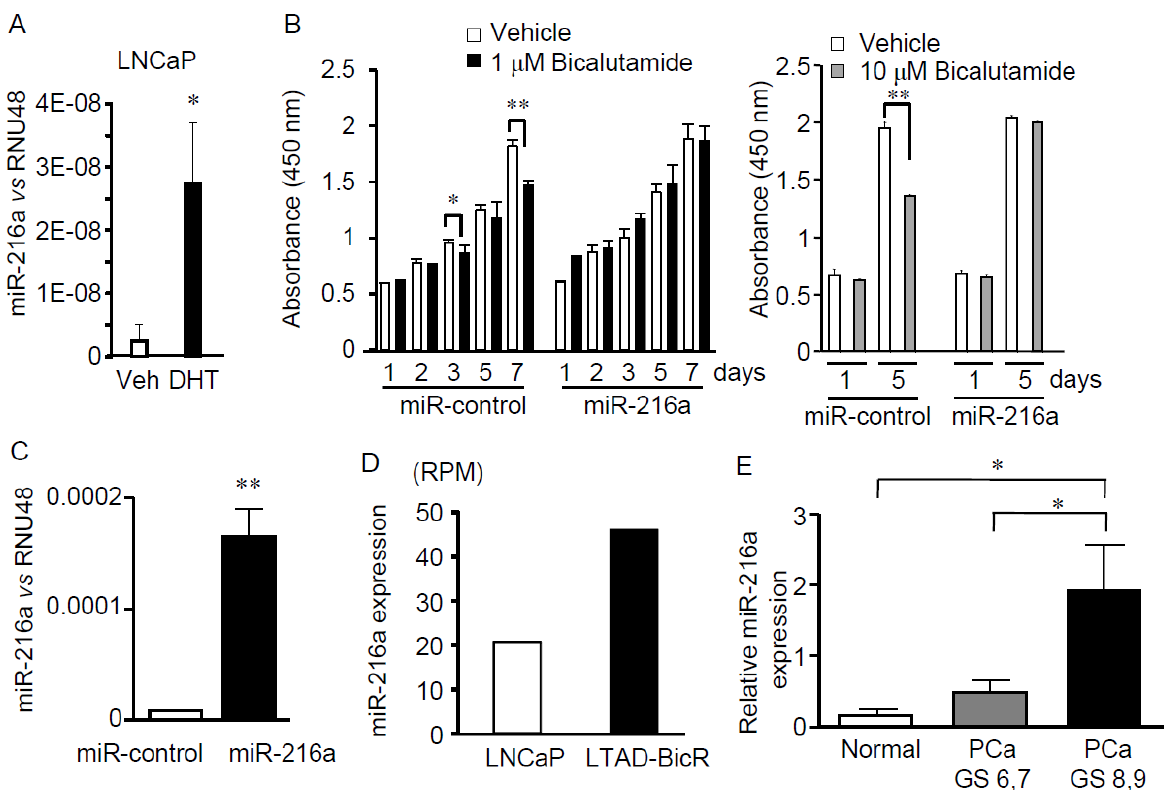
Figure 3. Overexpression of miR-216a inhibited bicalutamide-dependent suppression of LNCaP cell growth and upregulation of miR-216a in bicalutamide-resistant LNCaP cells and clinical prostate cancer samples. ( A ) Endogenous miR-216a expression is (phenol red-free medium with charcoal stripped FBS) were